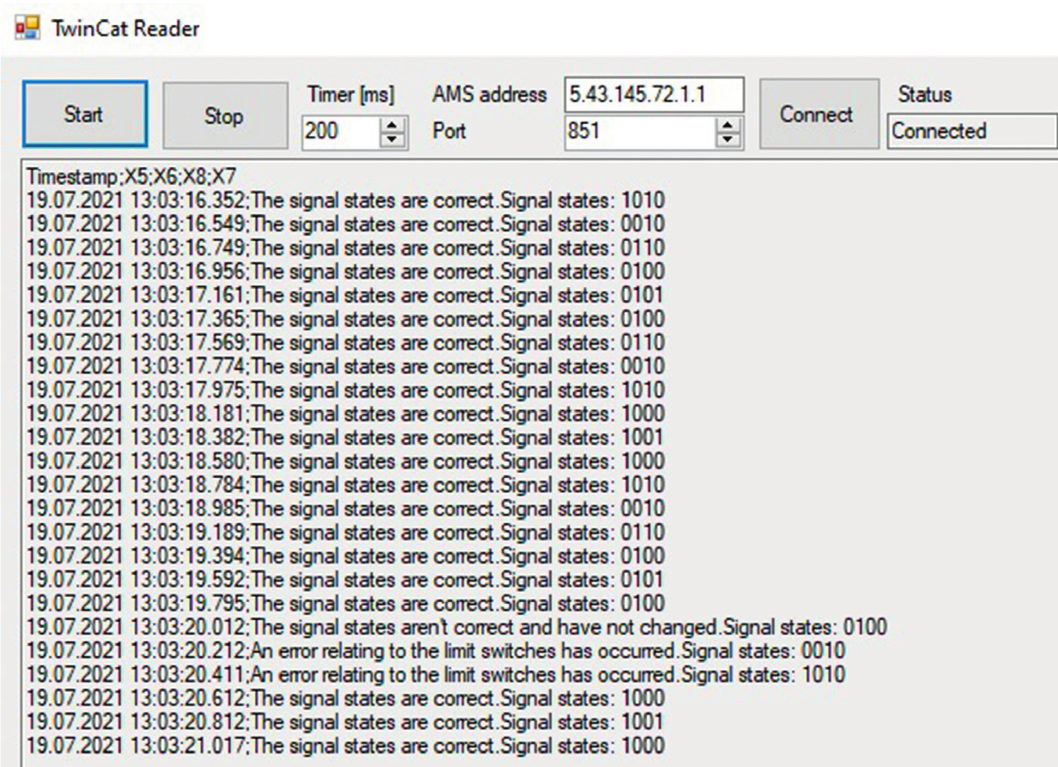
Figure 9: An example window showing the results of the